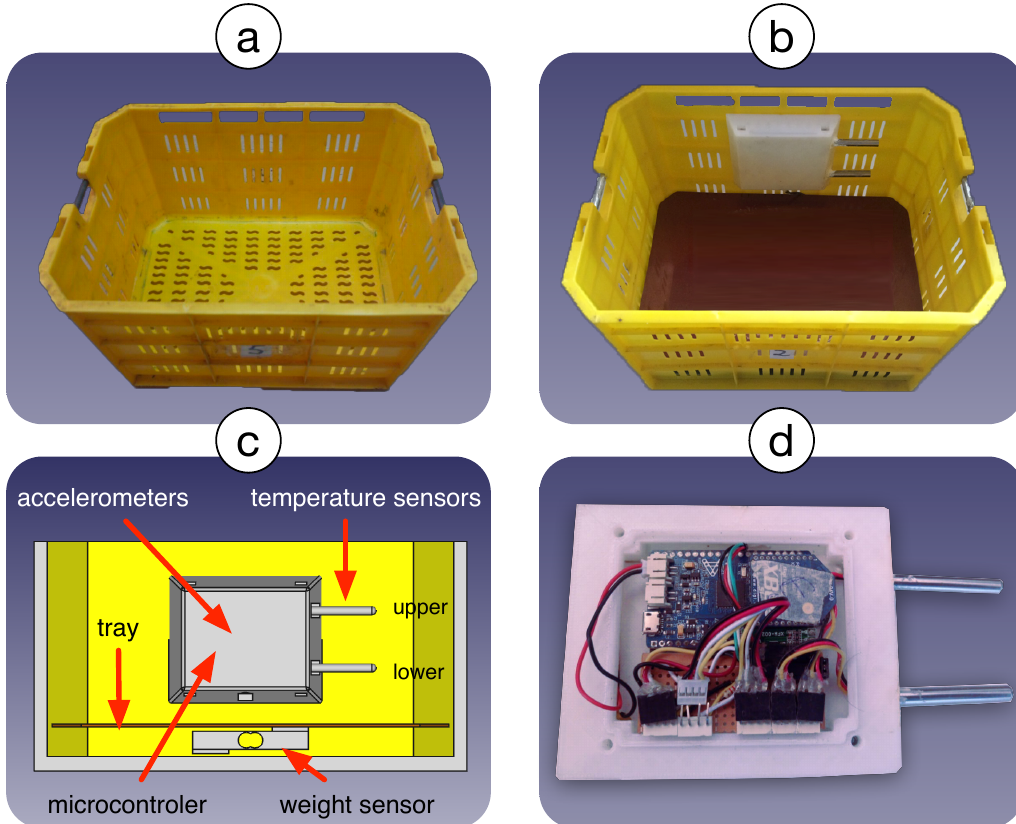
Figure 3. Different views of the 3.5 kg blueberry harvest basket. ( a ) Empty harvest basket. ( b ) Harvest basket with the monitoring system inside. ( c ) Vertical section of the basket with details of the housing of the electronic devices, temperature sensors (upper and lower), weighing tray, and weight sensor. ( d ) The internal electronics of the monitoring